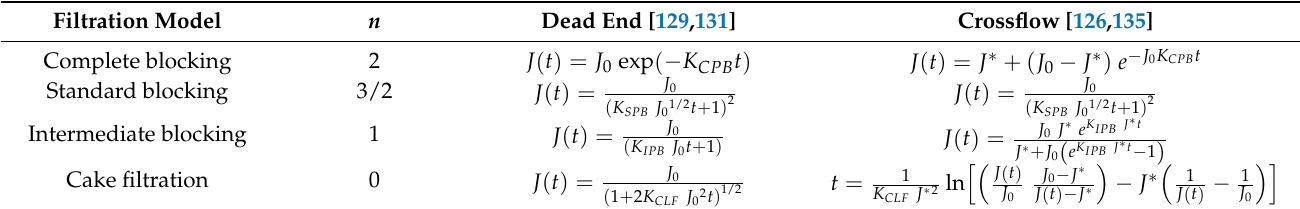
Table 1. Membrane fouling models for constant-pressure dead-end and crossflow